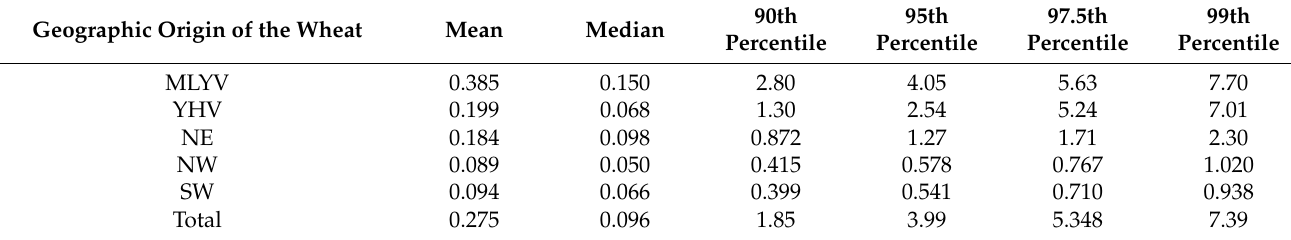
Table 6. The estimated dietary DON exposure through wheat-based products from different areas for adult women determined by point evaluation ( µ g/kg